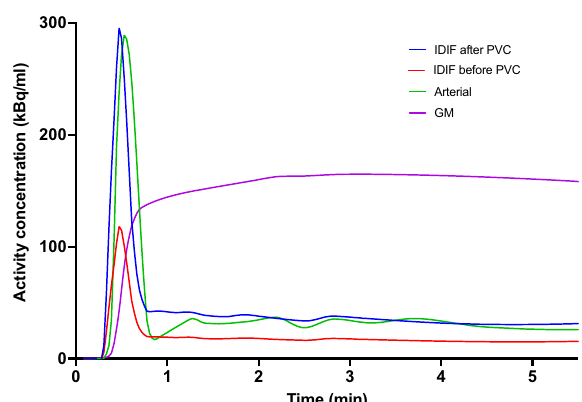
Fig. 4 Input curves for representative subject: BSIF (green), IDIF before PVC (red), IDIF after PVC (blue) and GM activity concentration (purple). BSIF blood-sampled input function. IDIF Image-derived input function. PVC partial volume correction. GM Grey matter